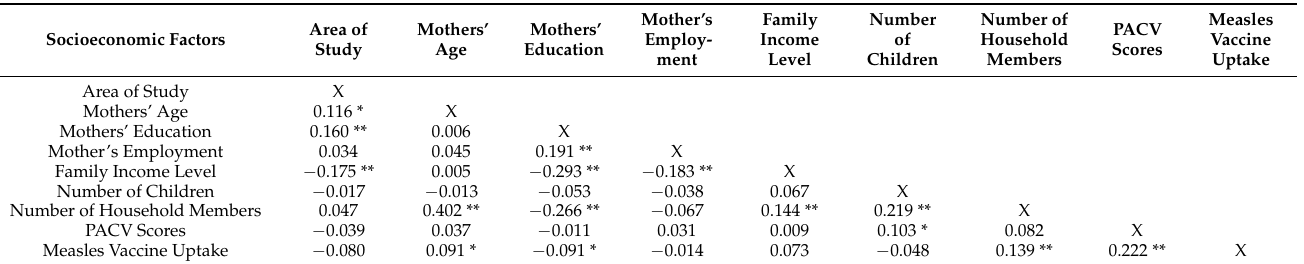
Table 2. Pearson correlations between measles vaccine uptake and the socioeconomic factors and measles vaccine hesitancy (PACV).